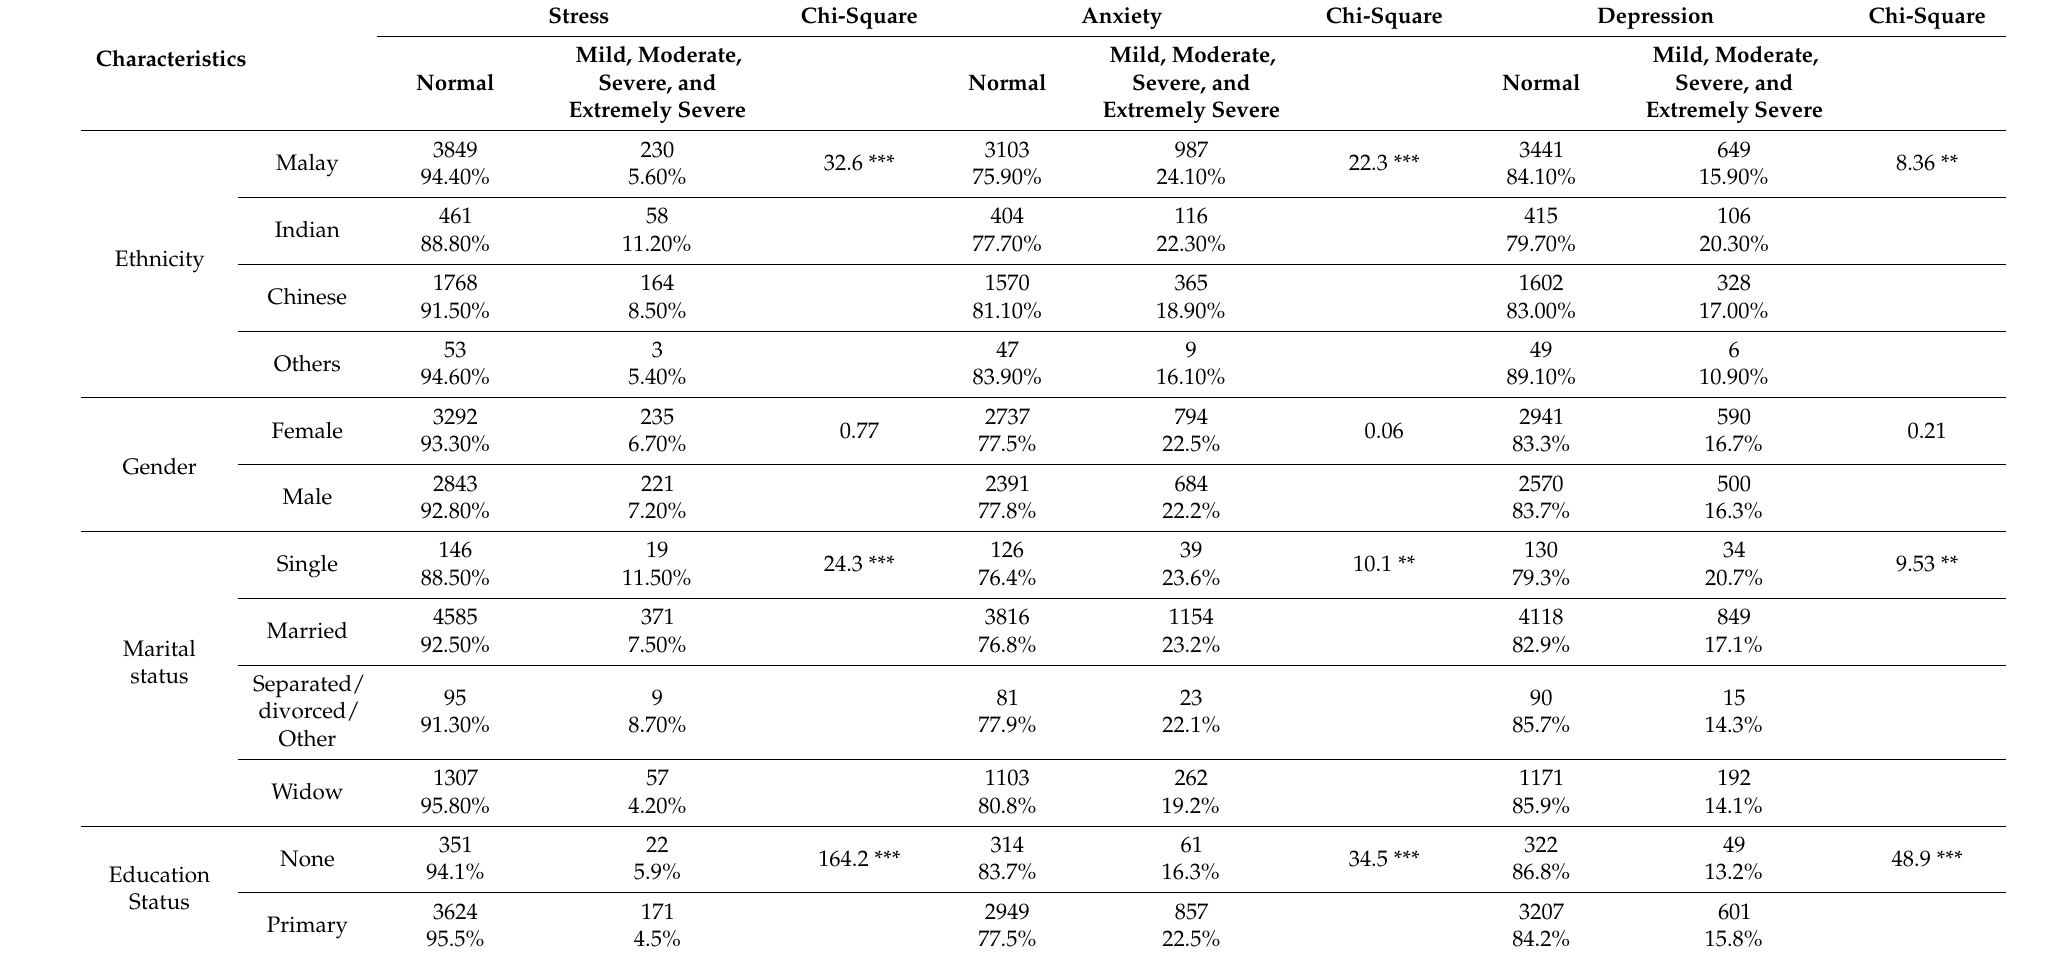
Table 1. Bivariate association between stress, depression, anxiety, and other predictor